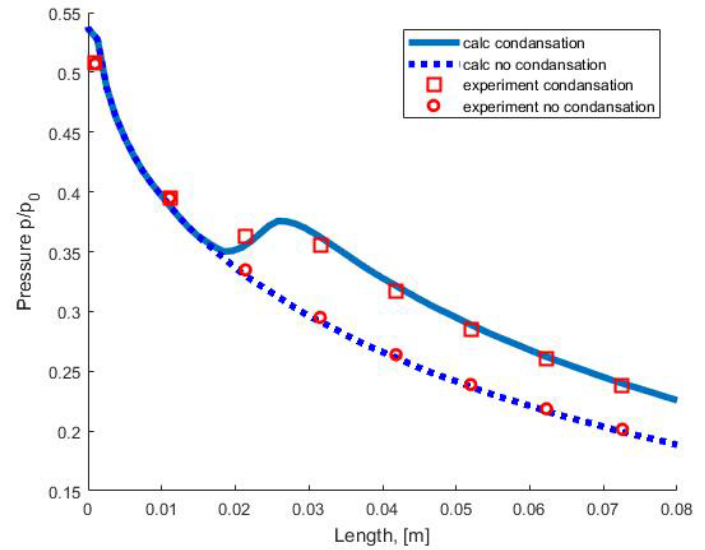
Figure 4. Computational domain for the plane nozzle.